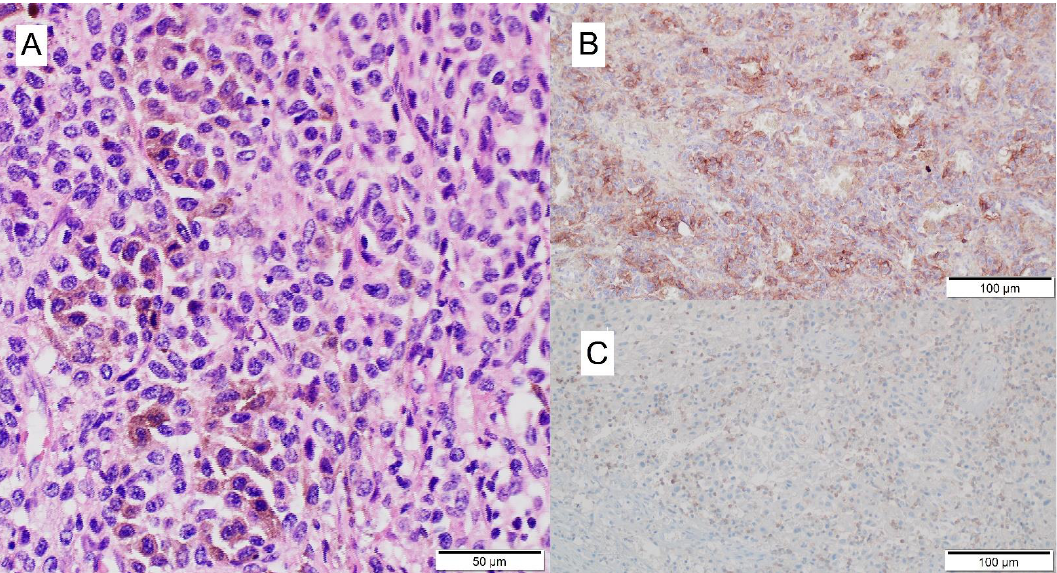
Figure 2. Histopathological presentation of primary lesion—malignant melanoma: Tumor composed of epithelioid melanocytes ( A ), which show PD-L1 expression ( B ); whereas lymphoid cells in the stroma present with PD-1 expression ( C ).